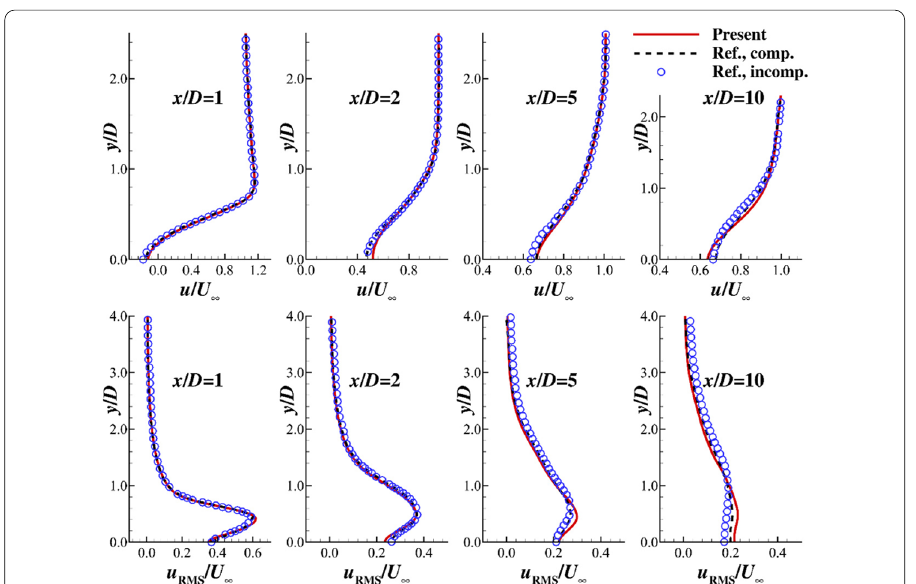
Fig. 6 Averaged streamwise velocity u and root-mean-square of u